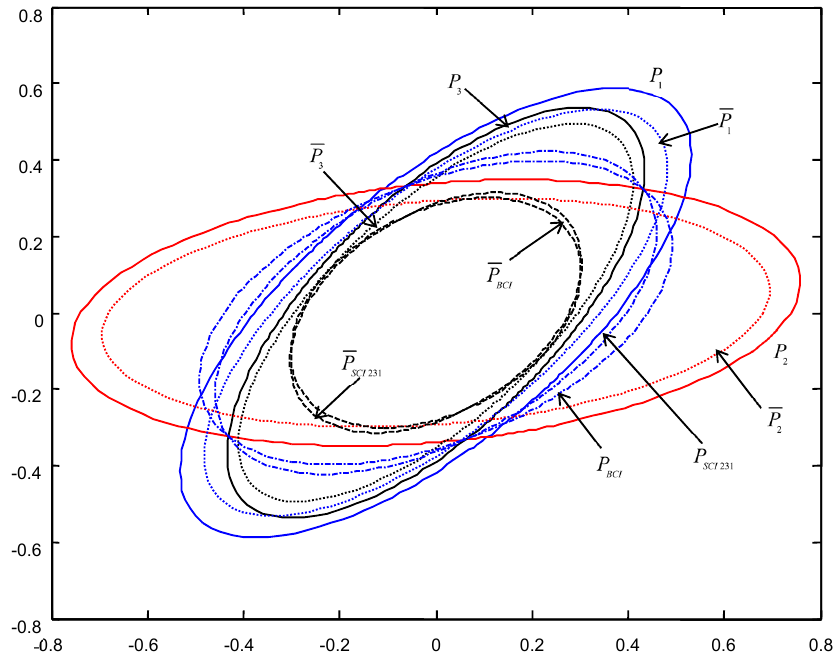
Figure 8. The ellipses of the actual and conservative time-varying filtering error variances of the order SCI 231 at t = 10.